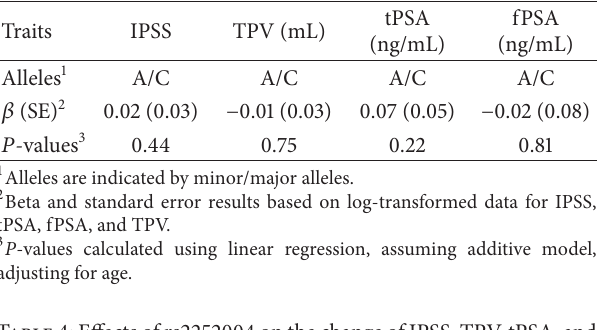
Table 4: Effects of rs2252004 on the change of IPSS, TPV, tPSA, and fPSA after treatment in BPH case